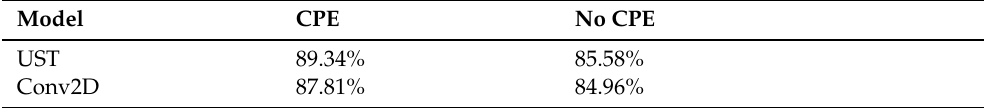
Table 11. A ablation study regarding the effectiveness of CPE.